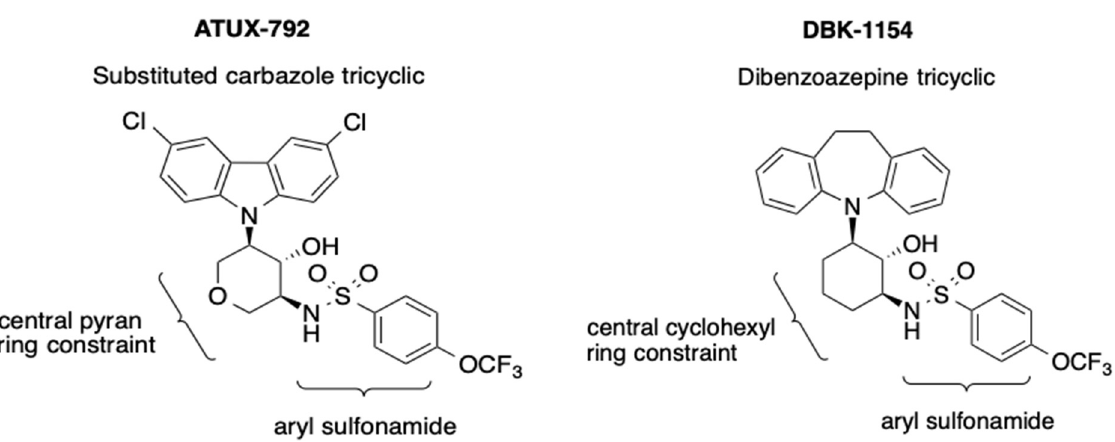
Figure 1. Tricyclic sulfonamides ATUX-792 (792) and DBK-1154 (1154). The compounds consist of a tricyclic moiety, a central ring constraint, and a pendant aryl sulfonamide. In 792 ( left panel ), the tricyclic is a substituted carbazole and in 1154 ( right panel ), the tricyclic is a dibenzoazepine. Table 1. ( A ) Microsome (oxidative metabolism) stability studies revealed a short half-life (T 1/2 ) and high clearance (CL) of 1154 in liver microsome assays. Longer T 1/2 and lower CL renders 792 stable with respect to oxidative metabolism. ( B ) Studies of time-dependent inhibition of CYP-3A4 showed none associated with 792, and a moderate effect with 1154.